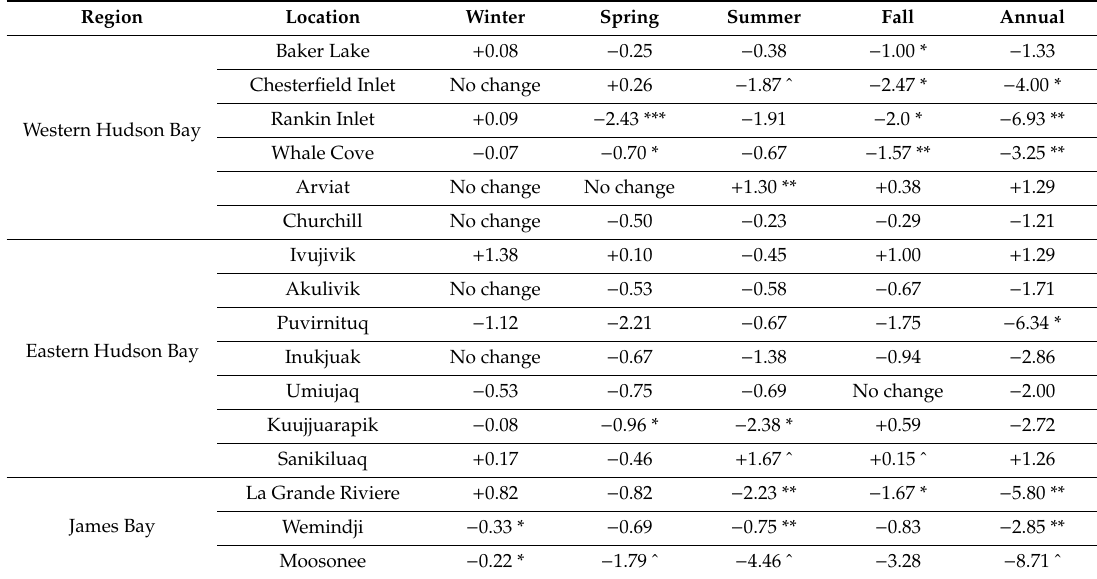
Table 3. Trends in fog hours per year with significance level adjusted for autocorrelation.